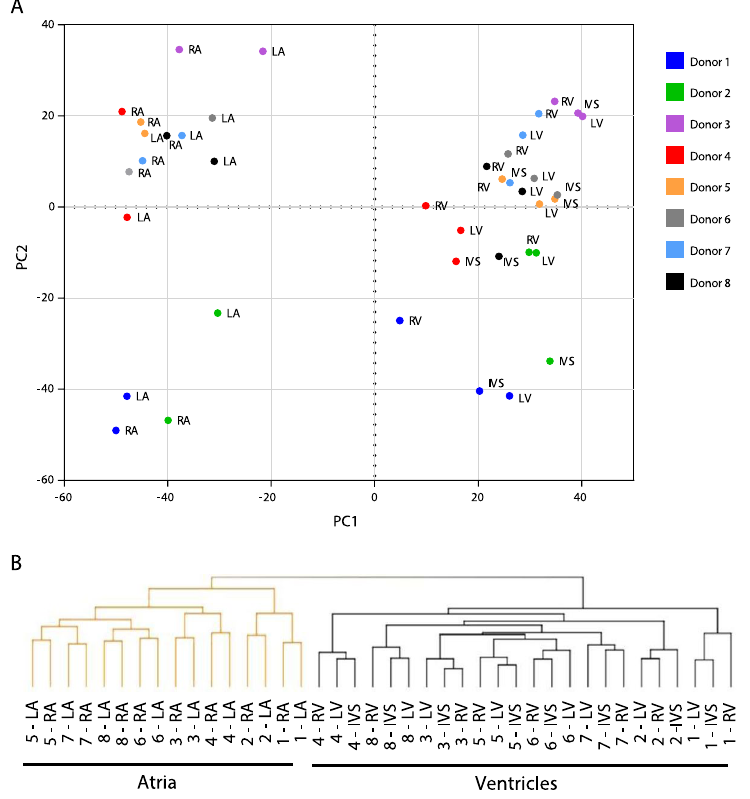
Figure 1. mRNA expression profiles in non-failing human atria and ventricles are distinct. ( A ) Principal component analyses of normalized read counts in all cardiac expressed mRNA transcripts distinguish the atrial and ventricular samples. The left (LA) and right (RA) atrial samples and, separately, the left (LV) and right (RV) ventricular and interventricular septum (IVS) samples cluster by donor. ( B ) Unsupervised hierarchical clustering of the expression profiles of human cardiac mRNAs also distinguish the atrial (orange), from the ventricular (black), samples. These analyses further clustered the LA and RA samples, as well as the LV, RV and IVS samples, by